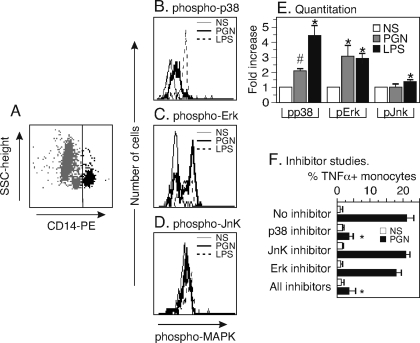
PGN stimulates the p38 MAP kinase and ERK pathways and TNFα is blocked by inhibition of p38 MAP kinase.(A) PB was stimulated with PGN (10 µg/ml) or LPS (1 µg/ml) and phospho-MAP kinases were measured by intracellular staining in CD14+ monocytes. (B) Phospho-p38 MAP kinase was measured after 15 min for the unstimulated (thin solid line), PGN (thick solid line), and LPS (dashed line). (C) Phospho p44/42 MAP kinase, 15 minutes and (D) phospho-JnK, 15 minutes. (E) Fold increase in phospho-MAP kinases for unstimulated (NS), PGN and LPS stimulation. Data are expressed as mean±SEM of three separate PB preparations. Statistical analysis was performed on MFI of stimulated PB versus MFI unstimulated PB. *, p<0.03; # p<0.005 by paired one-tailed t test. (F) PB was co-stimulated for 2 hours with PGN (10 µg/ml) with the MAP kinase inhibitors SB202190 (p38 MAP kinase inhibitor), SP600125 (JnK inhibitor) and PD 98095 (ERK inhibitor). TNFα in monocytes was measured by intracellular staining and flow cytometry. Data are expressed as mean±SEM of three separate preparations from two donors. Statistical analysis was by ANOVA with Bonferroni post test. *, p<0.01 versus PGN (10 µg/ml).